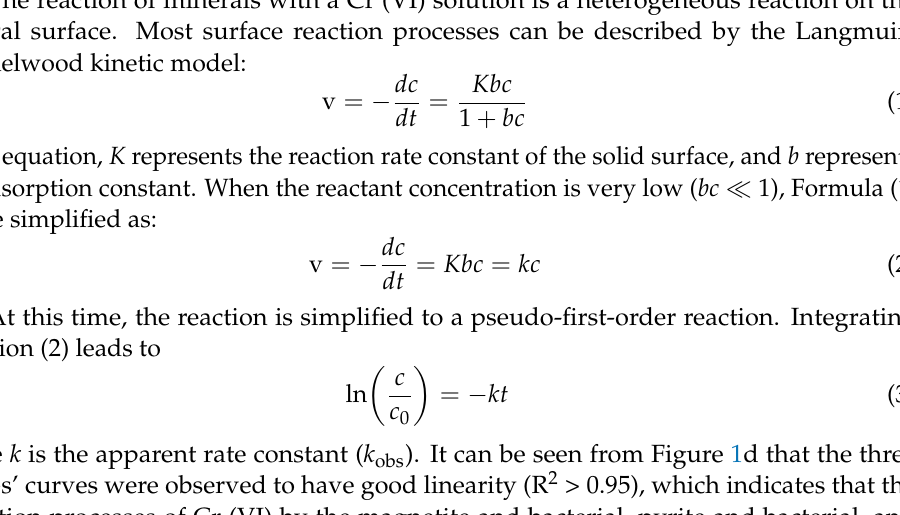
Figure 1. Changes in concentration of Cr (VI) with minerals: ( a ) pyrite with or without ERB, ( b ) magnetite with or without ERB, ( c ) recovery rates of Cr (VI) at 82 h, and ( d ) the kinetics of the Cr (VI) reduction process.